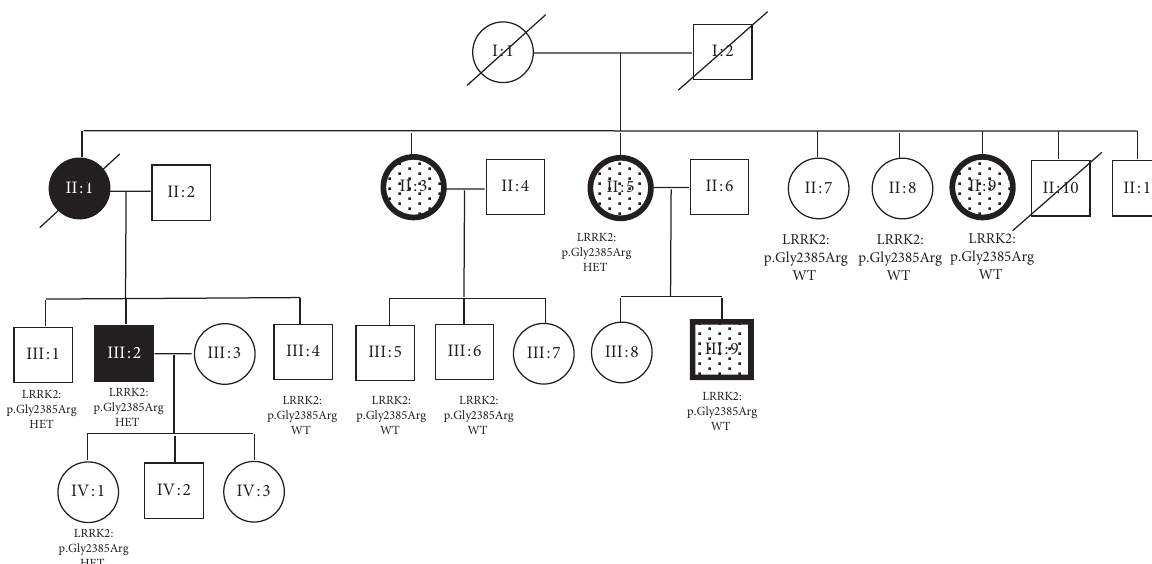
Figure 2: Familial case with p.Gly2385Arg variant. III:2 Proband 40 years old, PD onset at 38 years. II:1 Affected mother of the proband. PD onset at 55 years. Died at 58 years. Levodopa responsive PD. II:3 affected maternal aunt. 10 years’ history of unilateral right-hand tremor at rest and action. II:5 Affected maternal aunt, 54 years old. 10 years’ history of positional unilateral tremor. III:9 son of II:5. Right-hand positional tremor. II:9 Affected maternal aunt, 4-5 years’ history of right-hand positional